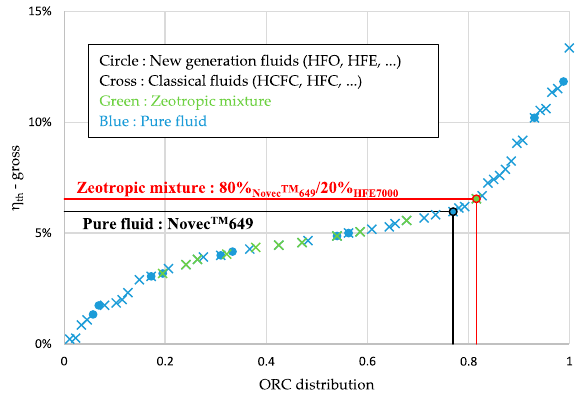
Figure 9. The ORCs’ distribution according to their gross thermal e ffi ciency.